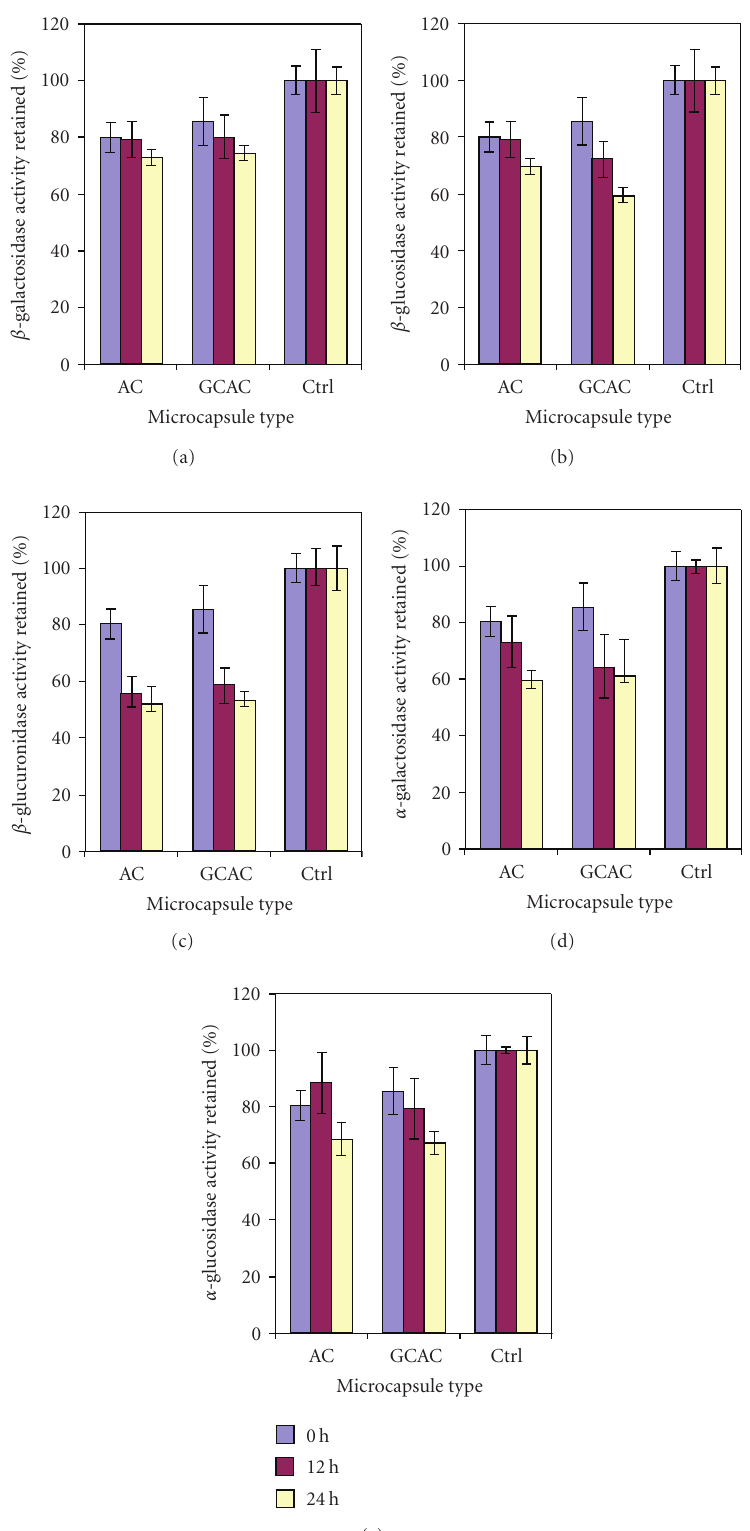
Figure 5: Percent microbial enzyme activities retained in the suspension of the simulated human transverse colon in the presence of microcapsules relative to that in the absence of microcapsules (control). Values for the controls at each time point were normalized to 100 % and were used to calculate the percent enzyme activities retained in the microcapsule-containing media at corresponding time points. (a) β -galactosidase; (b) β -glucosidase; (c) β -glucuronidase; (d) α -galactosidase; and (e) α